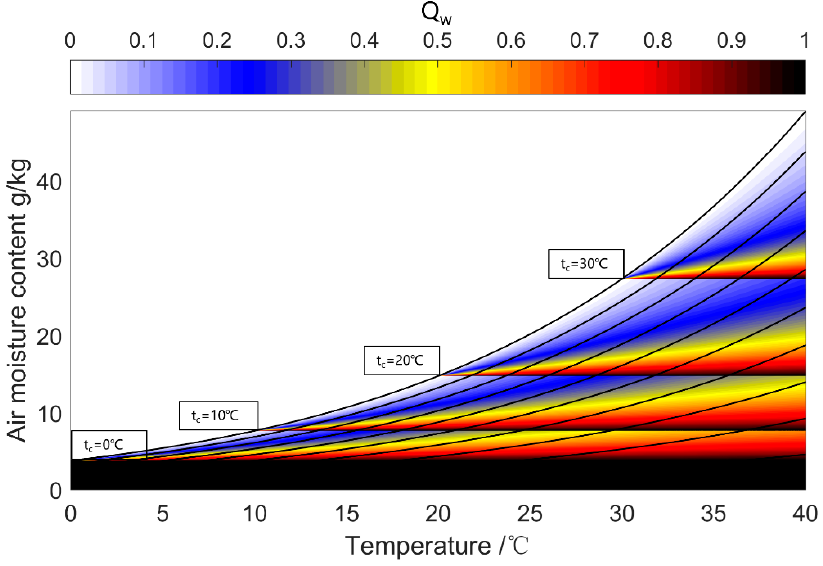
Figure 2. H c , the ratio of energy consumption to water mass harvested by the condensation method.